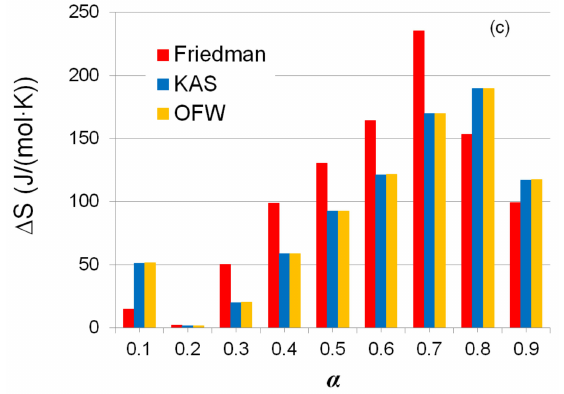
Figure 7. ( a ) ∆ H , ( b ) ∆ G , and ( c ) ∆ S of the pyrolysis of AIW. The change in ∆ G makes it possible to judge the energy available in biomass [6,49,95,96]. The ∆ G values for the studied AIW sample ranged from 147.90 to 150.78 kJ/mol by the Friedman method, 148.38–150.19 kJ/mol by the KAS method, and 148.38–150.18 kJ/mol by the OFW method. For most known biomasses and their mixtures, the ∆ G values are positive [87,90,95–98]. The resulting average value of ∆ G is 149.61 kJ/mol of the AIW sample. It is comparable to the ∆ G values for pseudo-hemicelluloses of cocoa shell (143.19 kJ/mol) [99], torrefied biomass of Acacia nilotica T-250 (159.97 kJ/mol) [100], and red macroalgae Gelidium floridanum for stage 1 (147.25 kJ/mol) [44], but higher than mustard stalk (128 kJ/mol) [78]. The data obtained indicate the high energy potential of